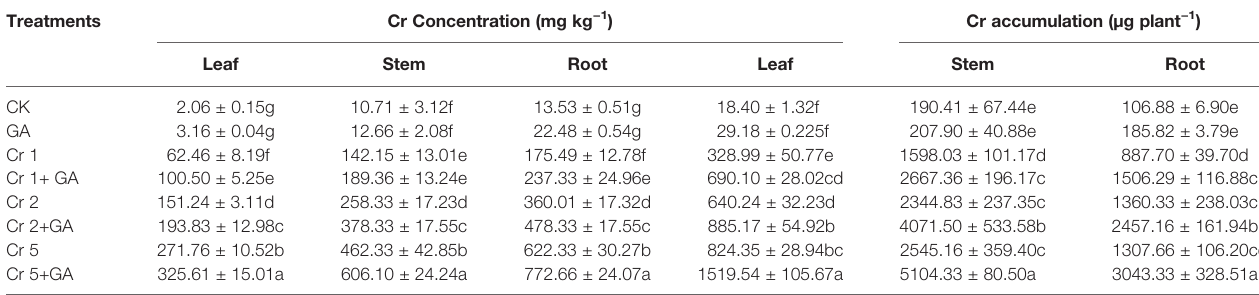
TABLE 2 | Effect of different concentrations of Cr alone and/or in combination with GA on Cr concentration and accumulation in sun fl ower.